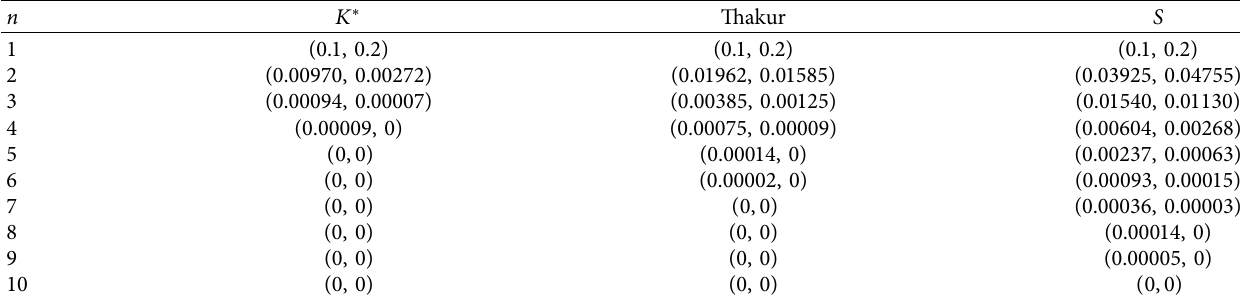
Table 3: Sequences generated by K ∗ -, Takur-, and S -iteration